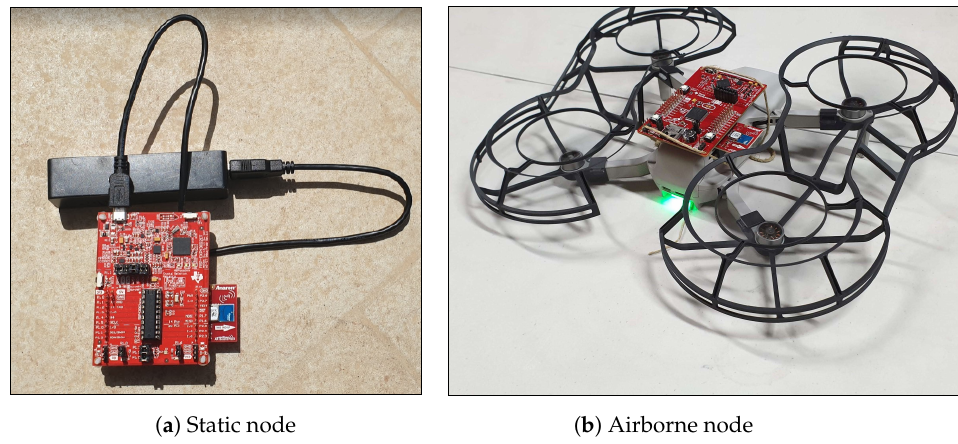
Figure 5. Evaluation system setup.